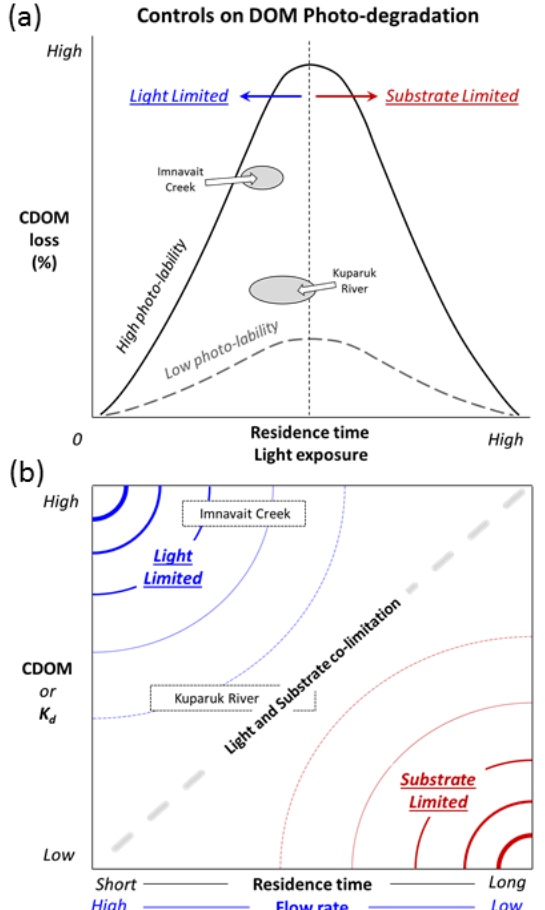
Figure 8. Controls on DOC photo-degradation. (a) As residence time or light exposure increase, so does DOC photo-degradation (% loss of the initial pool of CDOM, without replacement). The CDOM loss for any given light exposure is greater for higher photo-labile DOC (solid line) than it is for lower photo-labile DOC (dashed line). At low light exposure levels photo-degradation is “light- limited”, but after sufficient CDOM is lost the process switches to be “substrate-limited” (insufficient CDOM). (b) This shows the light- vs. substrate- limitation in terms of CDOM concentrations or light attenuation ( K d ) , y axis, and the water residence time or flow rate ( x axis). At high CDOM and short residence time there is in- sufficient light available for photo-degradation (upper left), while at low CDOM concentrations and long residence times there is abun- dant light yet insufficient CDOM. The range of conditions for DOC photo-degradation in Imnavait Creek is likely always light-limited, while in the Kuparuk River conditions may be substrate-limited at times.